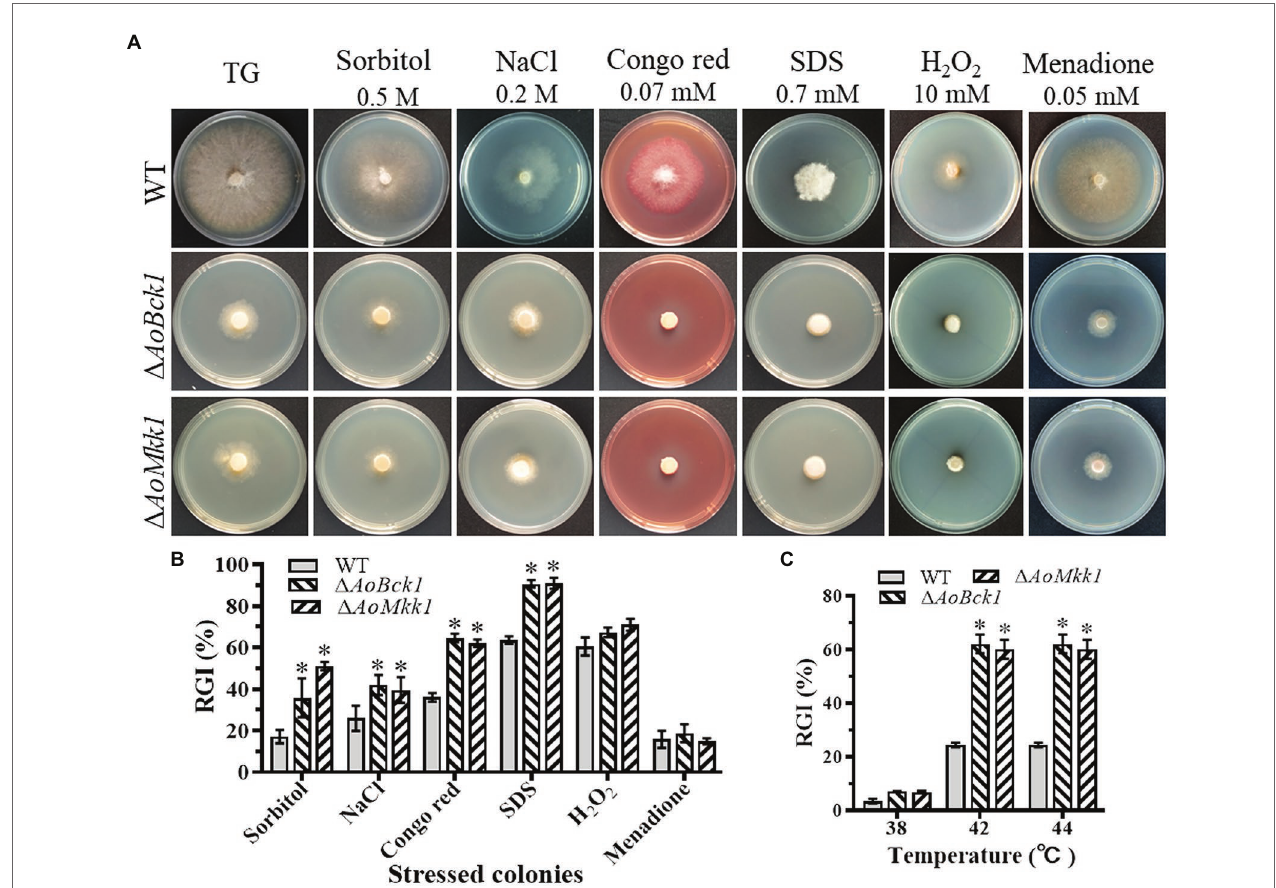
FIGURE 5 | Comparison of stress response between the WT and mutants. (A) Colonial morphology of fungal strains under stresses of osmotic, oxidative, and cell wall interfering agents stress. (B) Relative growth inhibition (RGI) of fungal colonies after 7 days grown at 28 ° C on TG plates supplemented with 0.2 M NaCl, 0.5 M sorbitol, 0.07 mM Congo red, 0.7 mM SDS, 10 mM H 2 O 2 , and 0.05 mM menadione. (C) RGI values of the WT and each mutant grown at different temperatures. An asterisk indicates a significant difference compared to the WT ( p <